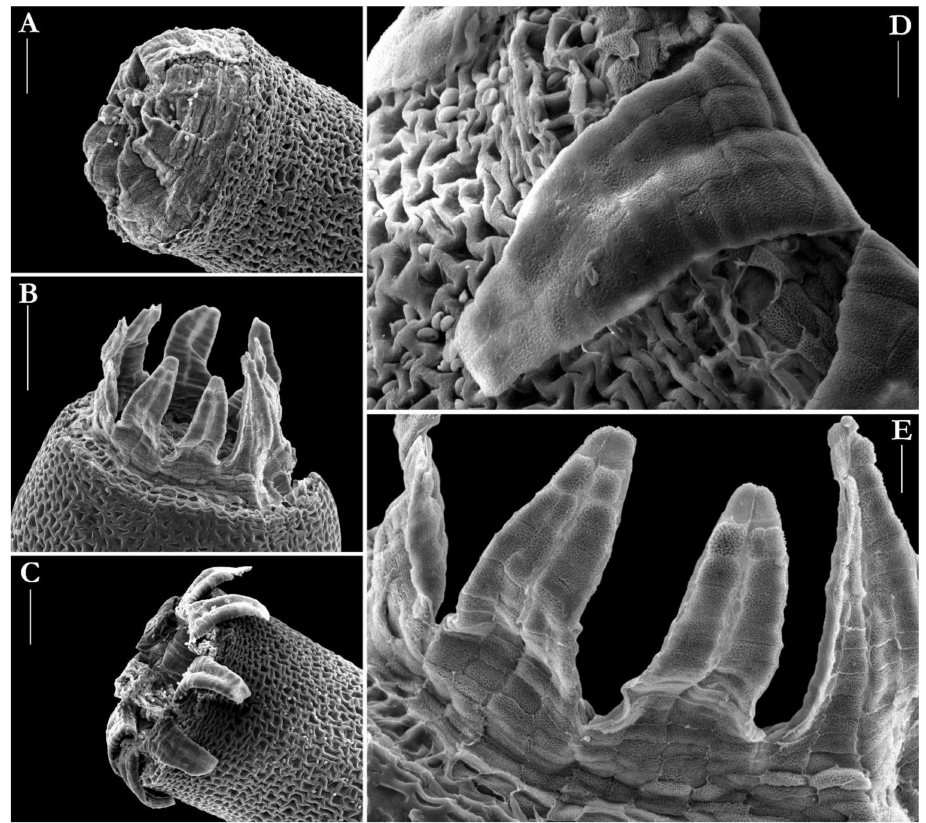
Figure 4. SEM micrographs of the capsule details of Splachnum pensylvanicum : ( A ) upper part of the urn showing peristome, spores and upper exothecial cells, ( B ) inflexed peristome teeth, ( C ) reflexed peristome teeth, ( D ) reflexed peristome tooth showing sculpture of its inner surface, ( E ) sculpture of the outer surface of the peristome teeth. All taken from KRAM B-242425. Scale bars: ( A – C )—100 µ m, ( D , E )—20 µ